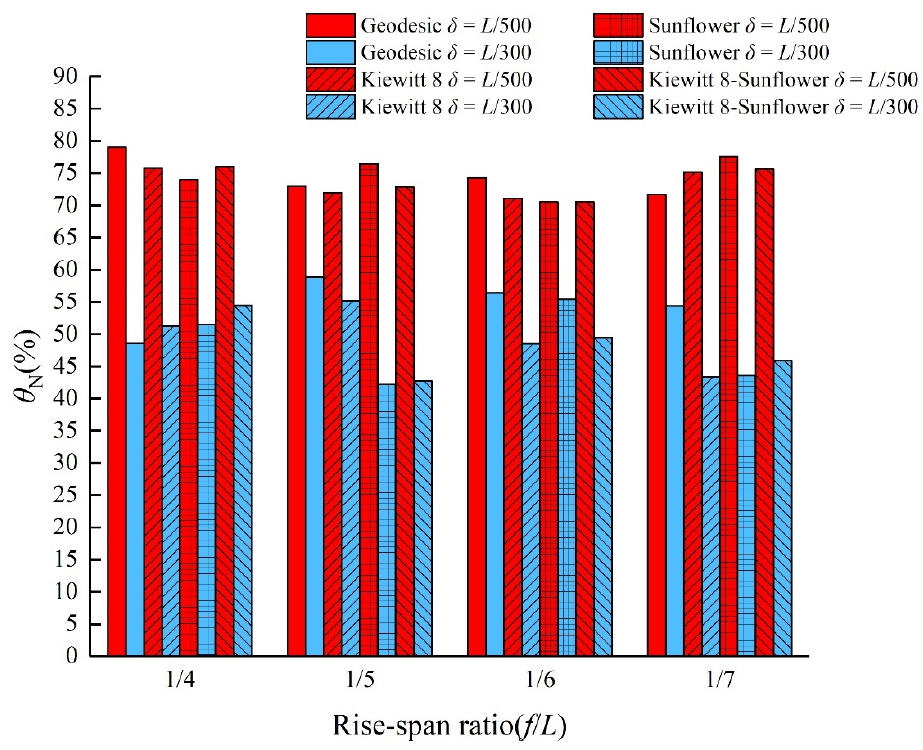
Figure 4. The average of percentage of MAS with L /300 and L /500.